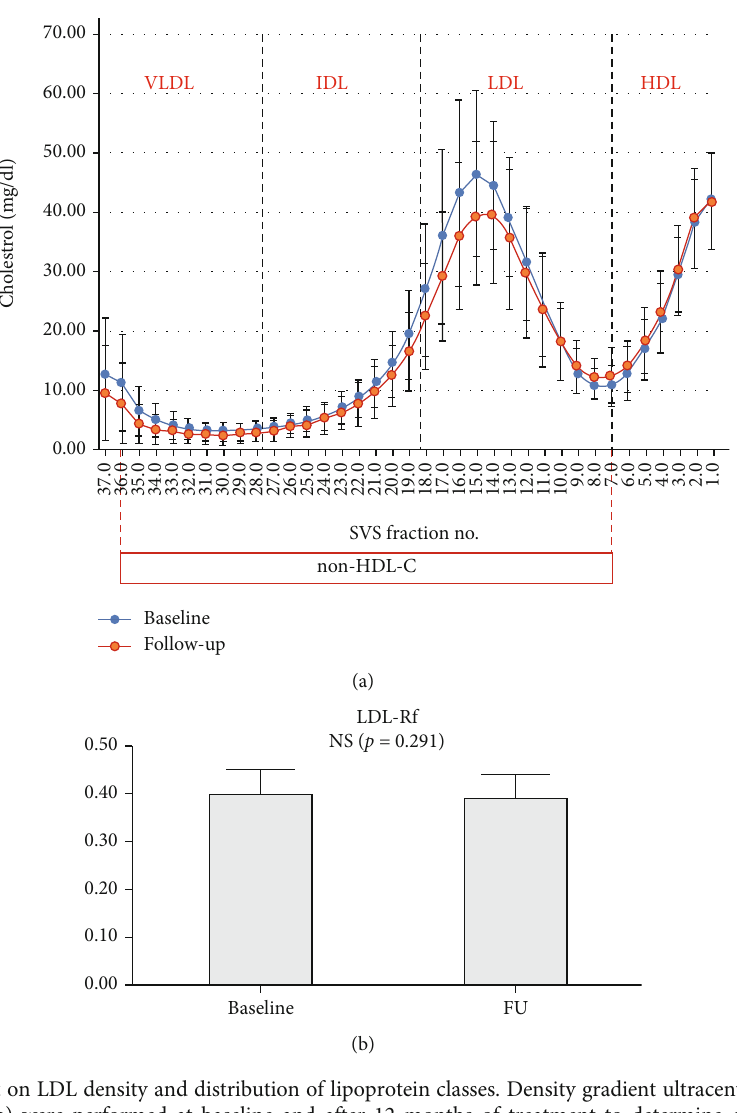
Figure 1: E ff ect of treatment on LDL density and distribution of lipoprotein classes. Density gradient ultracentrifugation (DGUC) (a) and relative fl otation rate (Rf) (b) were performed at baseline and after 12 months of treatment to determine changes in lipoprotein class distribution and LDL peak buoyancy, respectively. We found no signi fi cant modi fi cation in LDL density (b), whereas DGUC analysis showed a signi fi cant decrease in the LDL-c subfractions together with a trend of reduction in TG-rich lipoproteins (a) (VLDL: very low- density lipoproteins; IDL: intermediate-density lipoproteins; LDL: low-density lipoproteins; HDL: high-density lipoproteins; Non-HDL-c: non-HDL cholesterol; FU: follow-up).